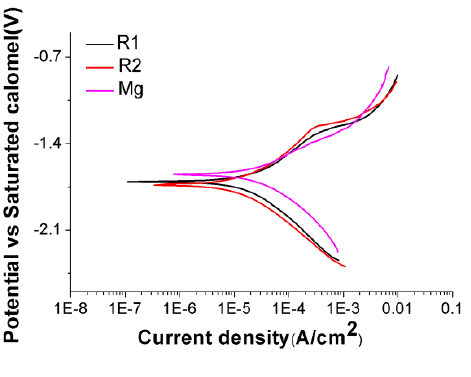
Figure 5. DC Polarization curves of three materials in